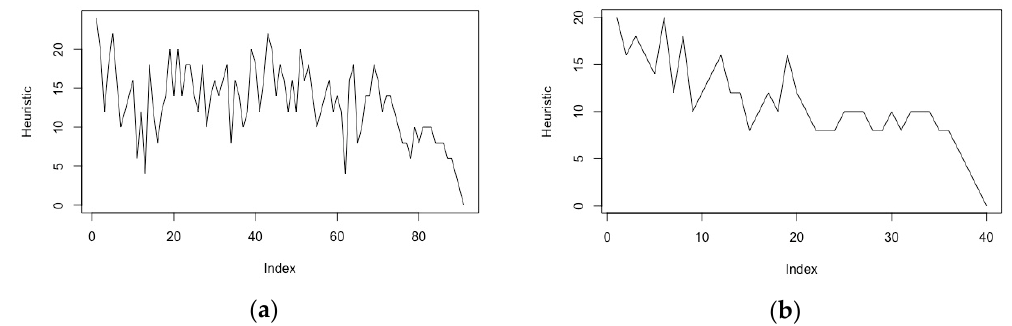
Figure 2. The impact of dynamic weighting on solution progression and backtracking. For the same configuration of the 8-puzzle ( a ) shows significant backtracking with a default heuristic function (A*), while in ( b ) WA* with fixed 0.575 weighting shows a more monotonic progression towards the goal state (as well as a faster computation).